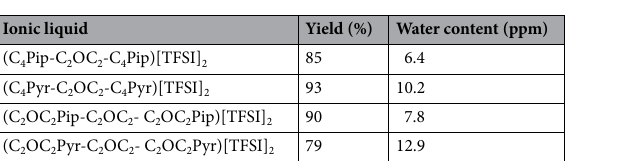
Ionic liquid Yield (%) Water content (ppm) (C 4 Pip-C 2 OC 2 -C 4 Pip)[TFSI]